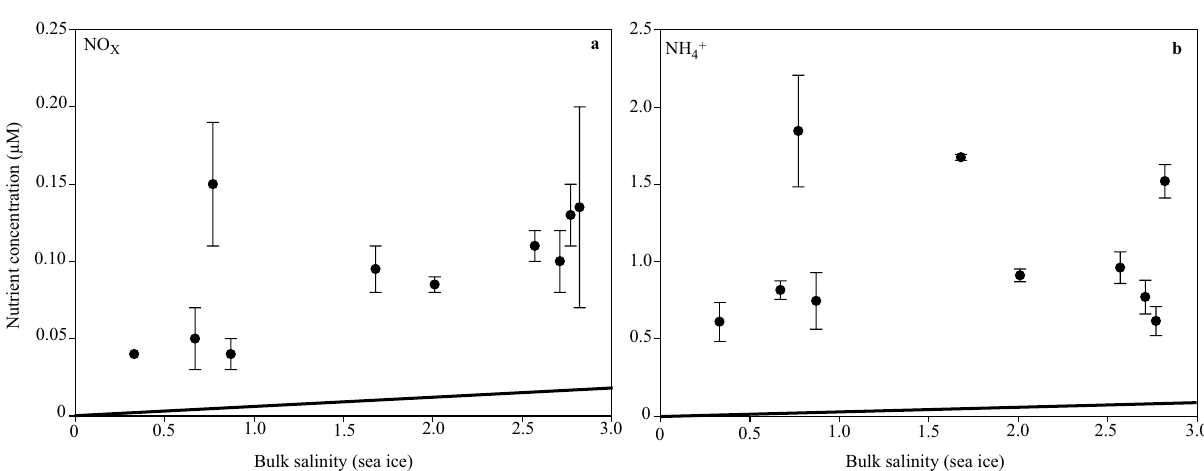
Figure 4. Sea ice nutrient concentrations in relation to salinity. Concentrations of ( a ) NO x and ( b ) NH 4 + versus bulk salinity in sea ice prior to the complete brine drainage event. The solid line indicates the expected dilution line predicted from salinity and nutrient concentrations in seawater (15 m depth, salinity of 33). Values below the dilution line indicate nutrient depletion; values above it indicates either production or net accumulation. Data points represents treatment mean ± SD (n =